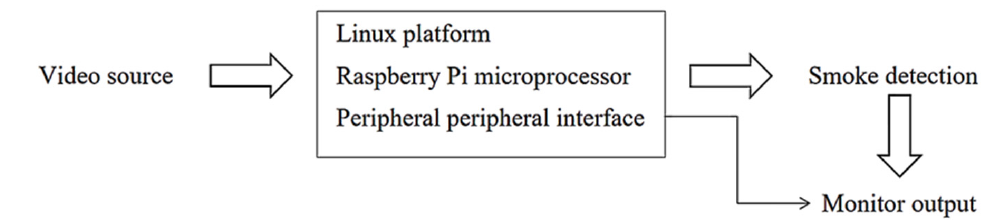
Figure 3. Hardware Design Block Diagram.